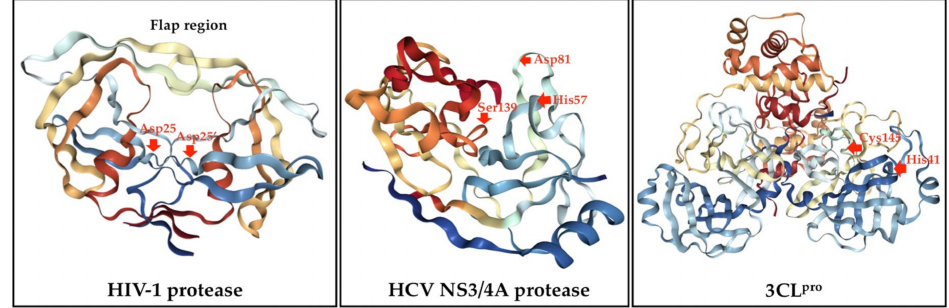
Figure 2. Crystal structures of HIV-1 protease (PDB: 2NMZ), HCV NS3 / 4A protease (PDB: 1DY8) and 3CL pro (PDB: 2DUC). The catalytic sites are